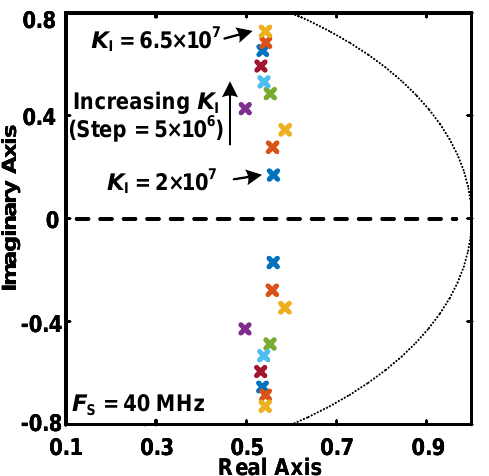
Figure 3. The pole plot of the proposed system under variable integration gain (x shown in Figure